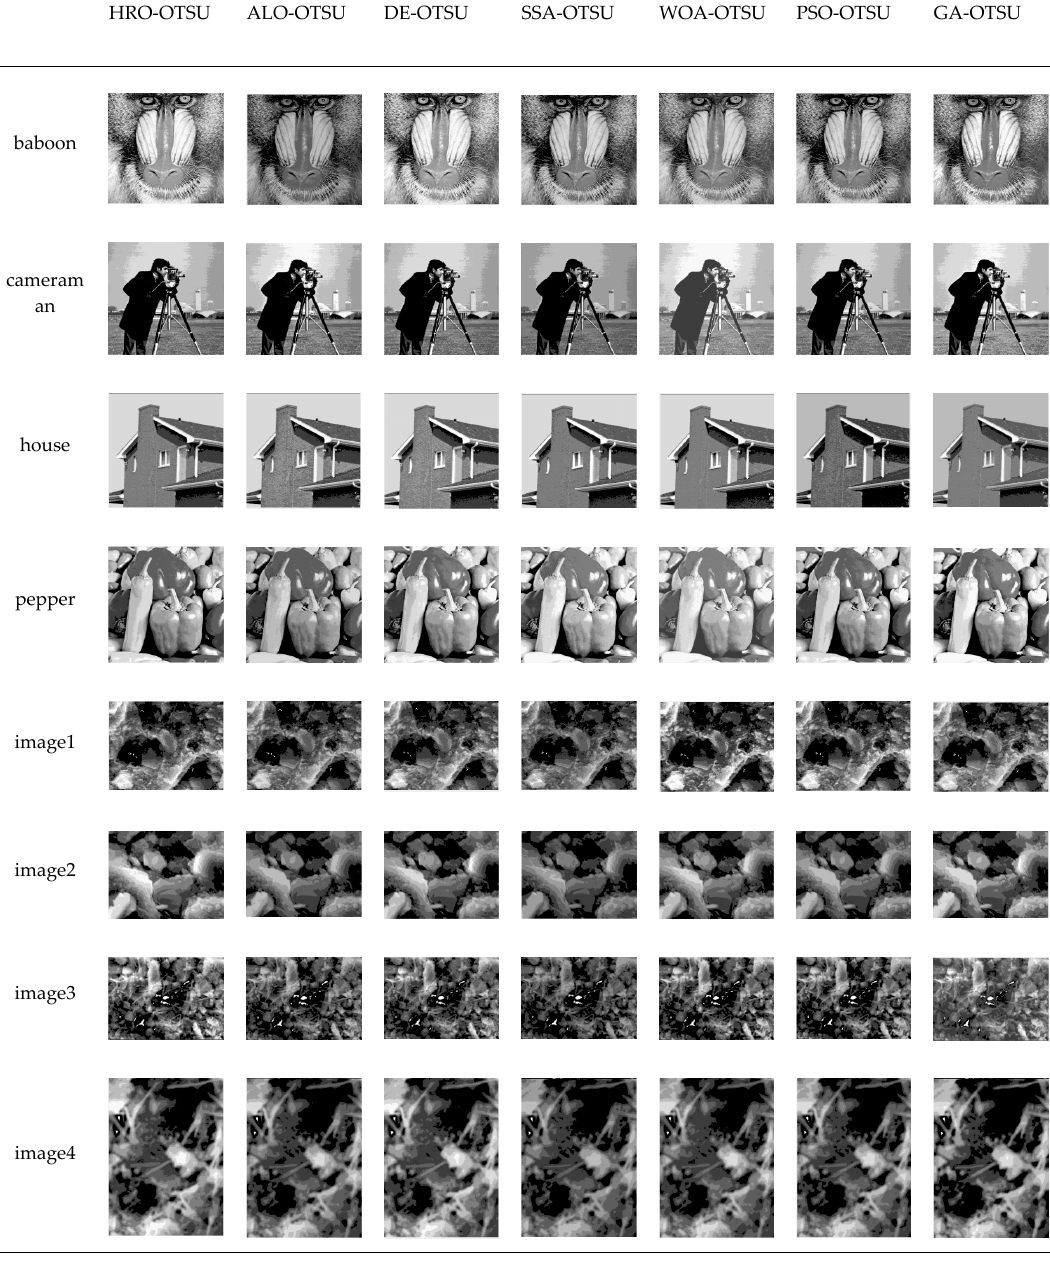
Figure 7. Segmented image obtained from the methods of HRO-OTSU, DE-OTSU, PSO-OTSU, SSA-OTSU, ALO-OTSU, WOA-OTSU, GA-OTSU.